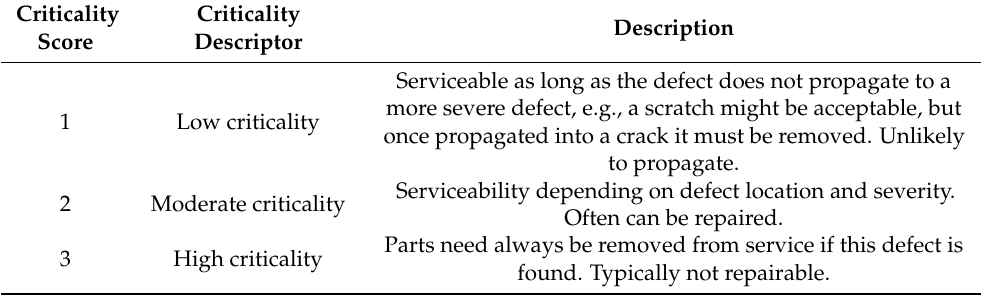
Table 5. Qualitative criticality scoring